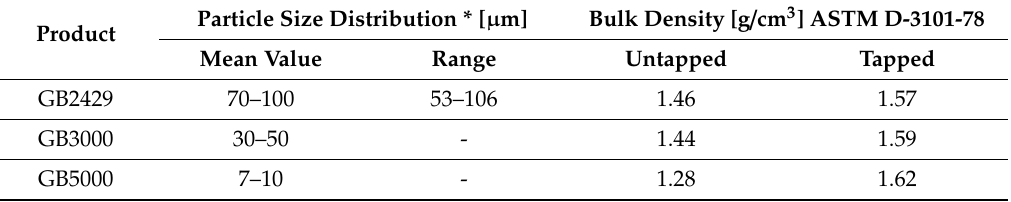
Table 1. Particle size and bulk density of the used glass beads as specified by the manufacturer.